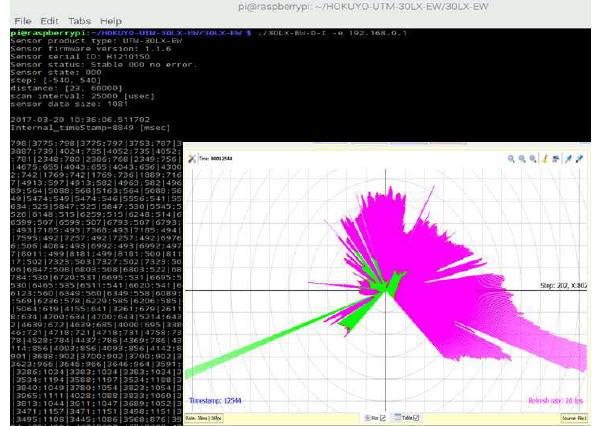
Figure 8. Data collection from Laser range Scanner and then plotting it in UrgBenri software